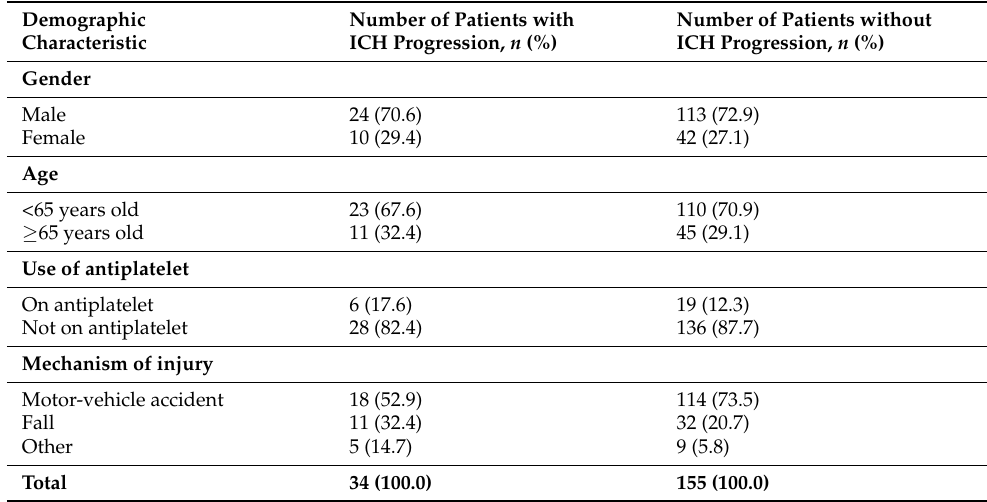
Table 1. Demographic characteristics of the patients in relation to ICH progression. Demographic